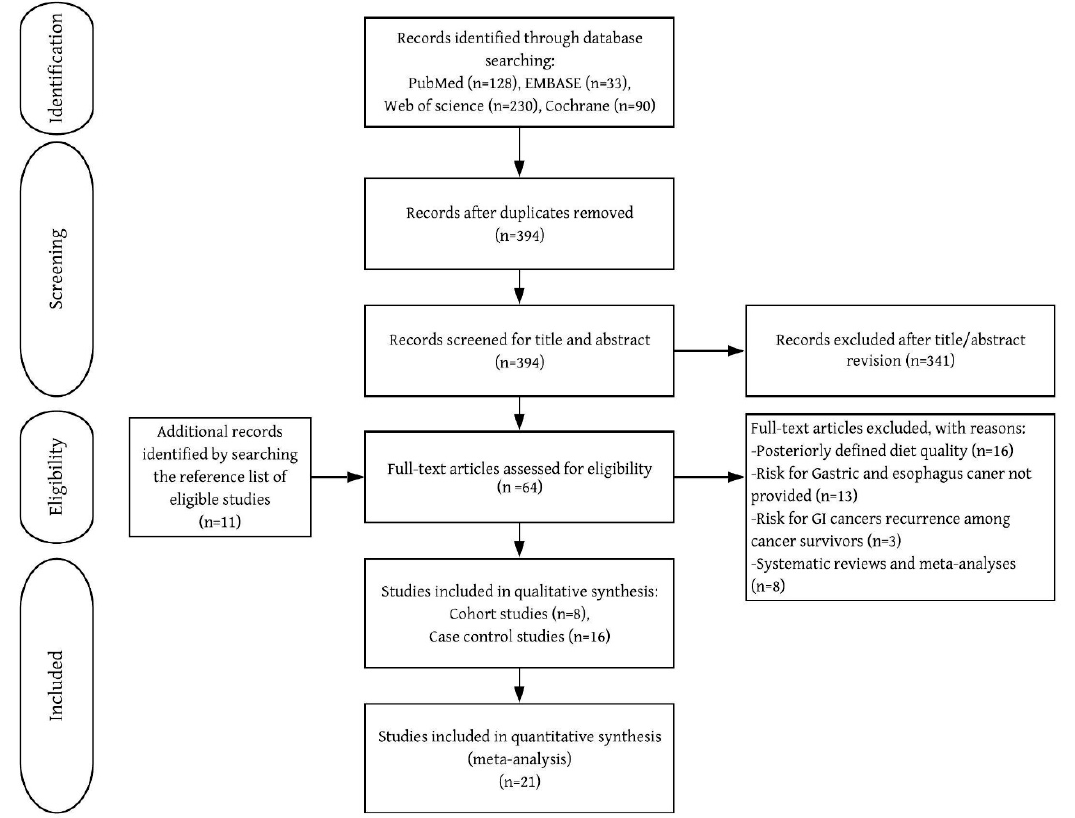
Figure 1. Flow chart of inclusion of relevant studies .